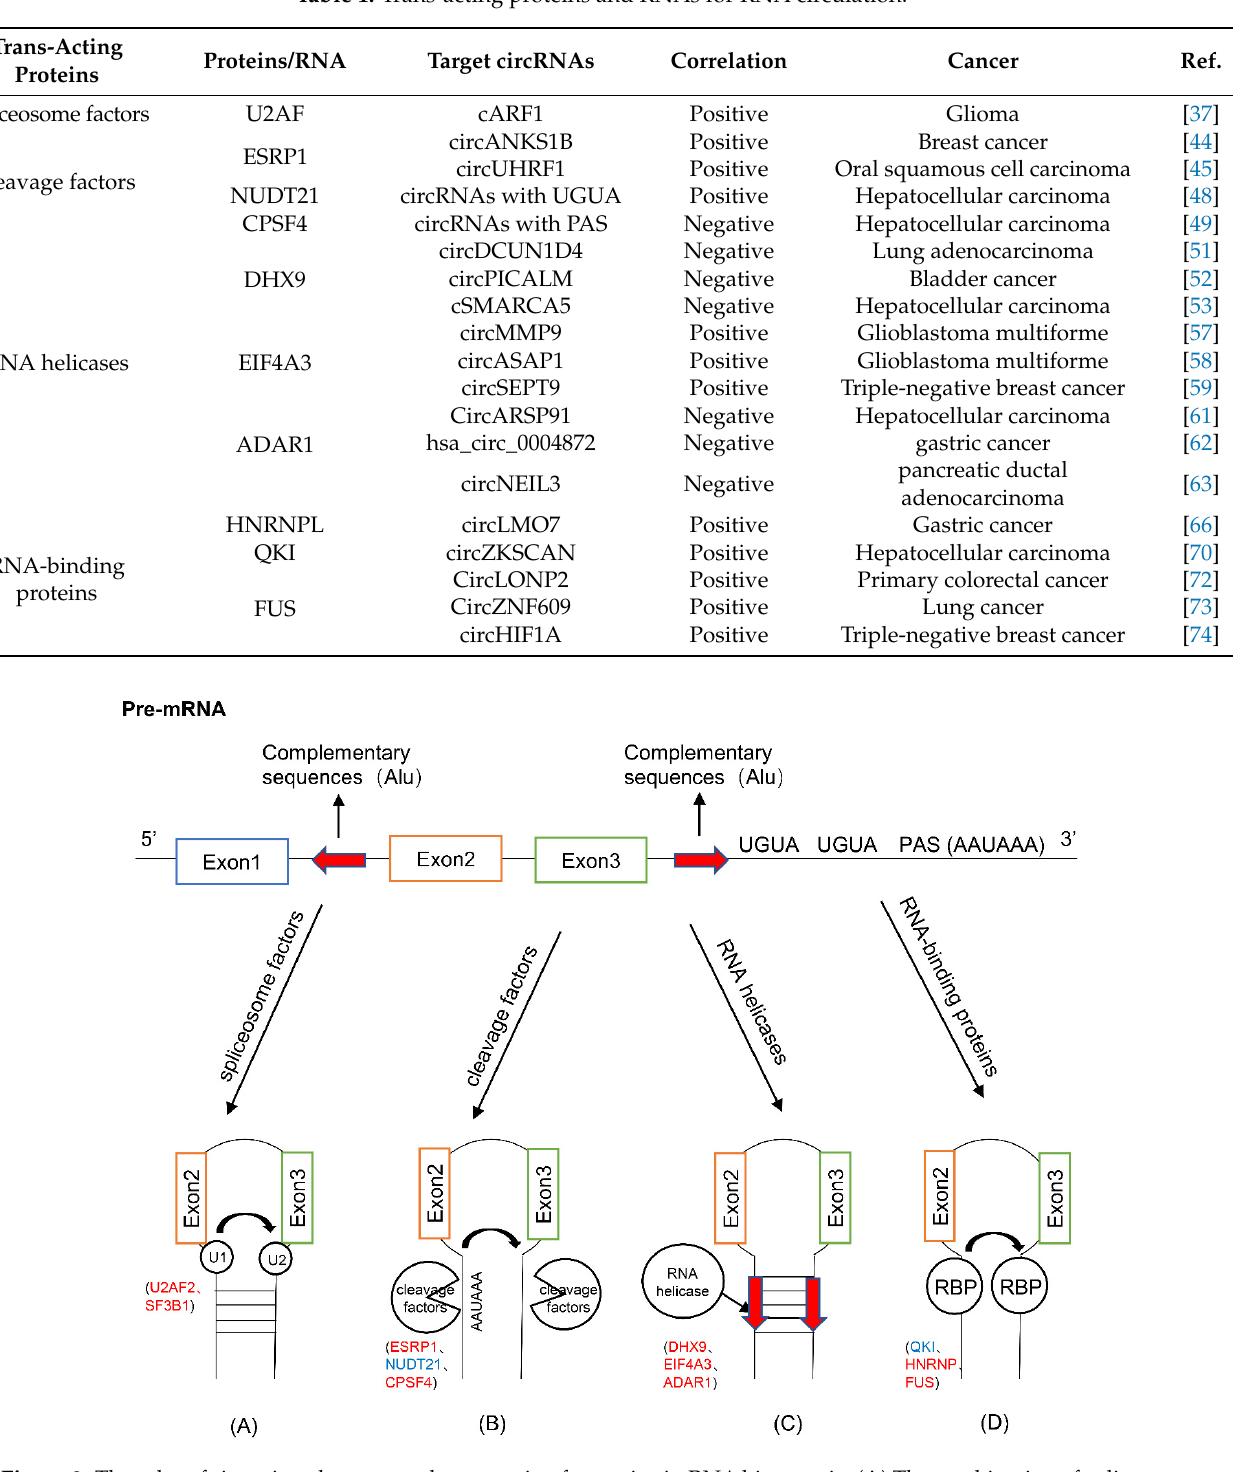
Figure 2. The roles of cis-acting elements and trans-acting factors in circRNA biogenesis. ( A ) The combination of spliceosome factors (U2AF2, SF3B1) with pre-mRNA binding sites. ( B ) Cleavage factors (ESRP1, NUDT21, CPSF4) directly cleave the cis-acting elements (PAS, UGUA) on pre-mRNA. ( C ) RNA helicases (DHX9, EIF4A3, ADAR1) unwind or interfere with the intron complementation Sequence (Alu). ( D ) RNA-binding proteins (QKI, HNRNP, FUS) bind to the pre-mRNA binding site to make the splice sites close. For the trans-acting factors, the ones labeled in red indicate increased expression in cancer, and the blue ones indicate decreased expression in cancer. Table 1. Trans-acting proteins and RNAs for RNA circulation. Ref.